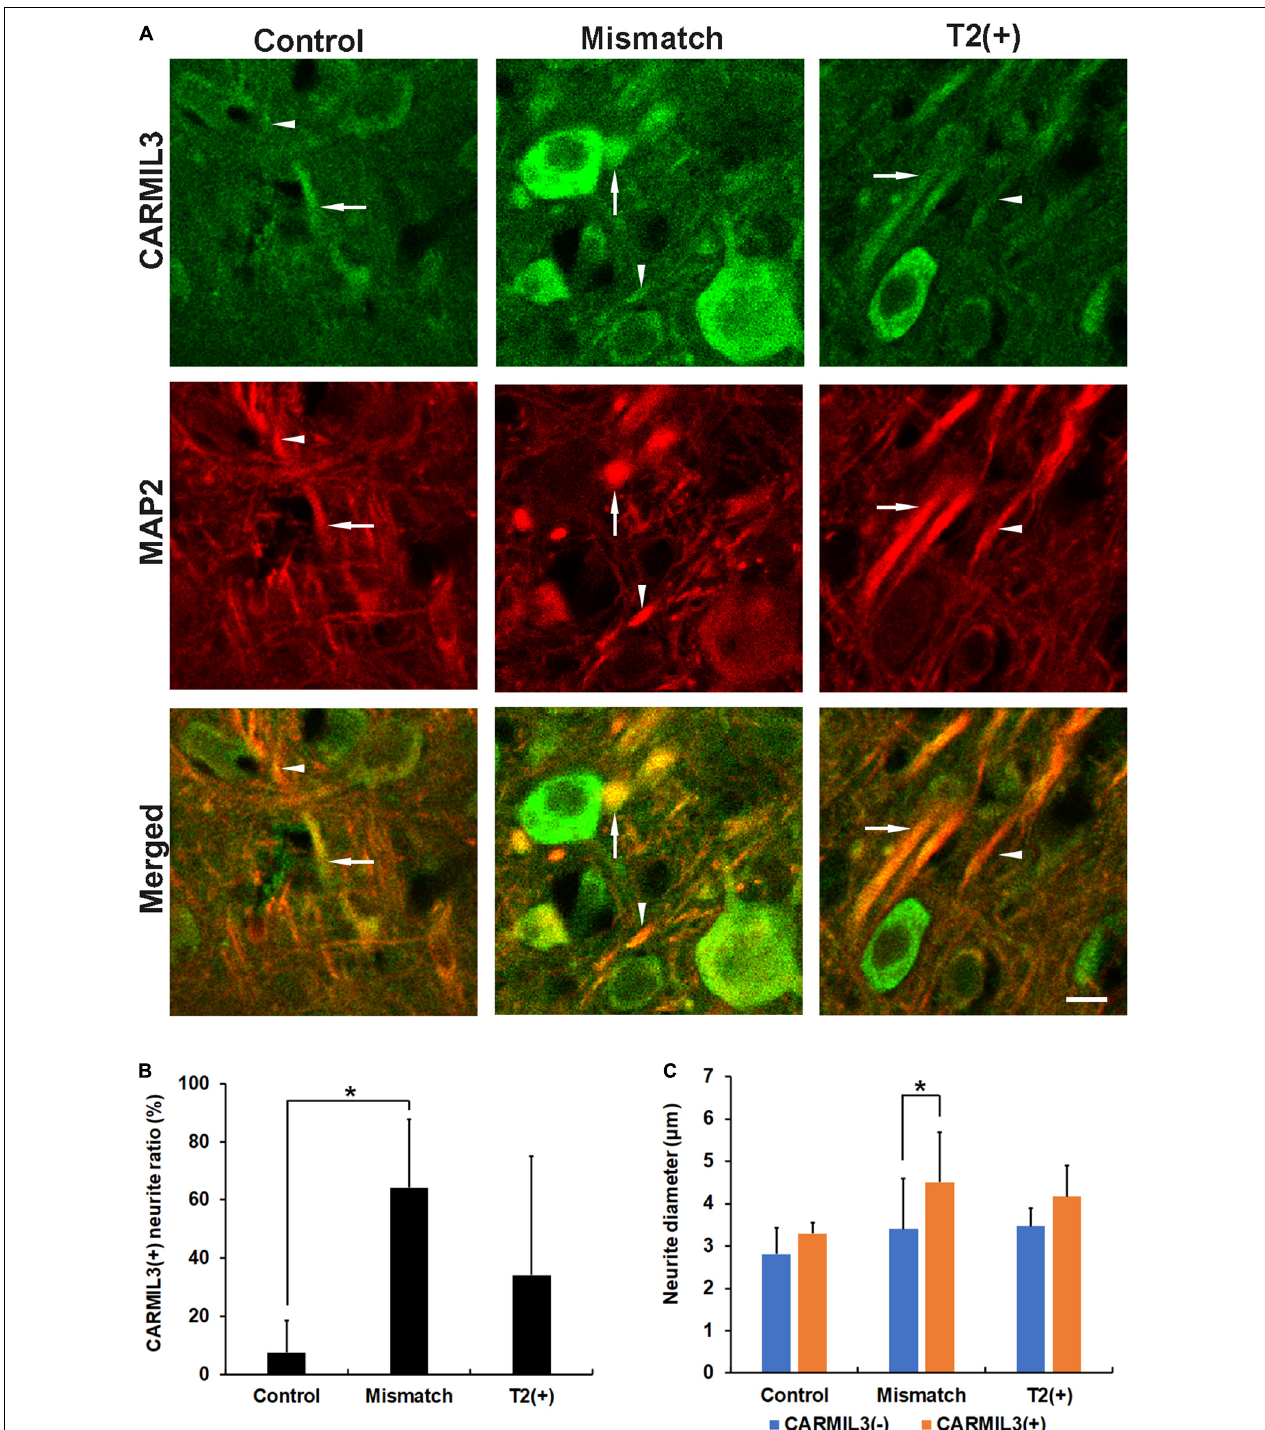
FIGURE 5 | Expression pattern of MAP2 in the CARMIL3(+) profiles. (A) Double labeling of CARMIL3 and MAP2 in the T2(+), mismatch, and control regions after pMCAO. The CARMIL3(+) profiles were colocalized with MAP2, indicating that CARMIL3(+) profiles were located on neurites. CARMIL3(+) neurites (arrows) were thicker than CARMIL3( − ) neurites (arrowheads) in the mismatch region. (B) CARMIL3(+) neurite ratio [the number of CARMIL3(+) neurites divided by that of all identifiable neurites] in the three regions. There were significantly higher ratios of CARMIL3(+) neurites in the mismatch regions compared with control areas ( p = 0.035). (C) Comparison of the neurite diameters of CARMIL3(+) and CARMIL3( − ) neurites. CARMIL3(+) neurites had significantly larger neurite diameters than CARMIL3( − ) ones in mismatch regions ( p = 0.036). * p < 0.05. N = 4 rats in each group. Scale bar = 10 µ